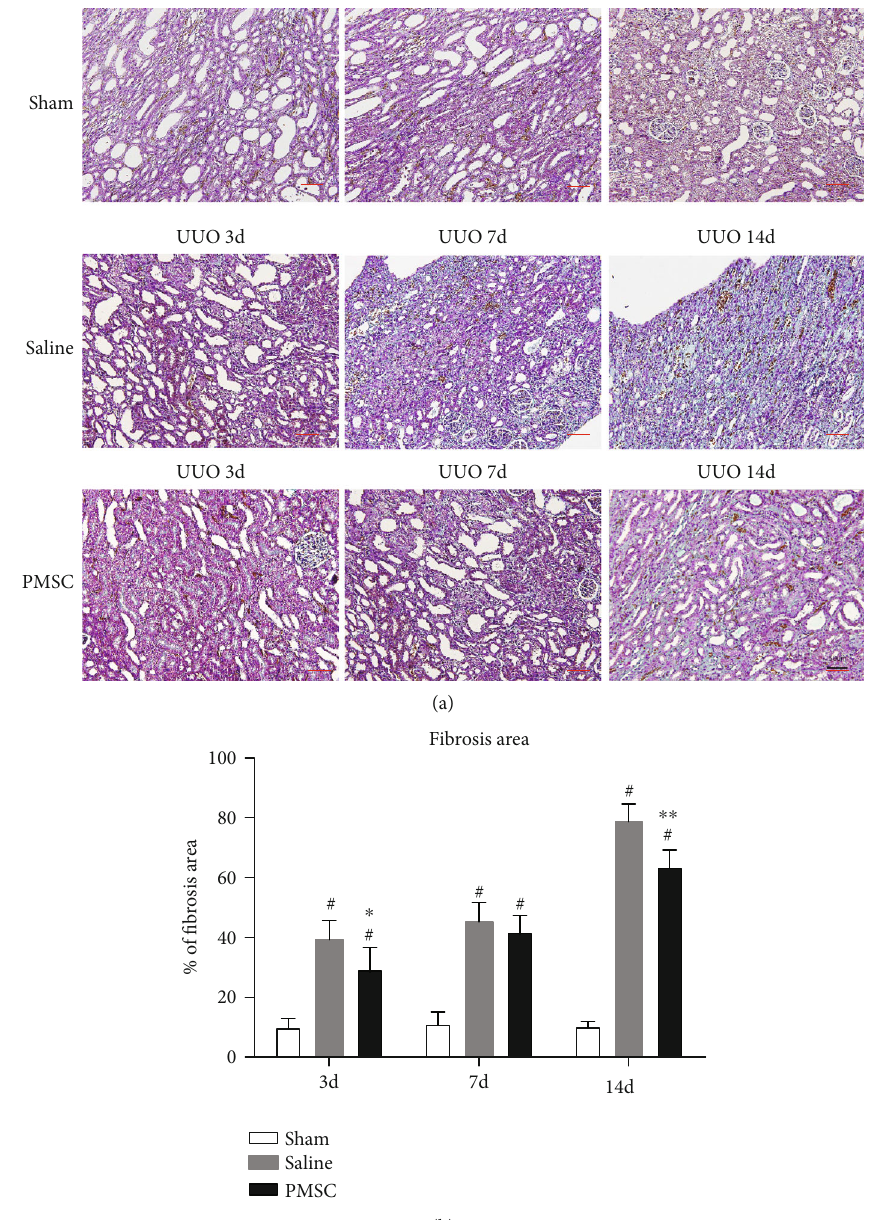
Figure 2: PMSCs regulate the UUO rat renal tubulointerstitial fi brosis. (a) Masson ’ s trichrome staining of kidney sections from normal, saline, and PMSCs treated rats at day 3, 7, and 14 after UUO. Sham group ( n = 5 ) represents the kidney from untreated rats after 3, 7, and 14 days, respectively. Saline group ( n = 5 ) represents saline-treated kidney subjected to UUO after 3, 7, and 14 days, respectively. PMSC group ( n = 5 ) represents PMSCs treated kidney at 3, 7, and 14 days, respectively. Scale bar: 50 μ m. (b) Tubulointerstitial in fi ltration was quanti fi ed by image analysis using NIS Elements (Nikon). ∗ P < 0 : 05 compared with Saline group; ∗∗ P < 0 : 01 compared with Saline group; # P < 0 : 05 compared with Sham